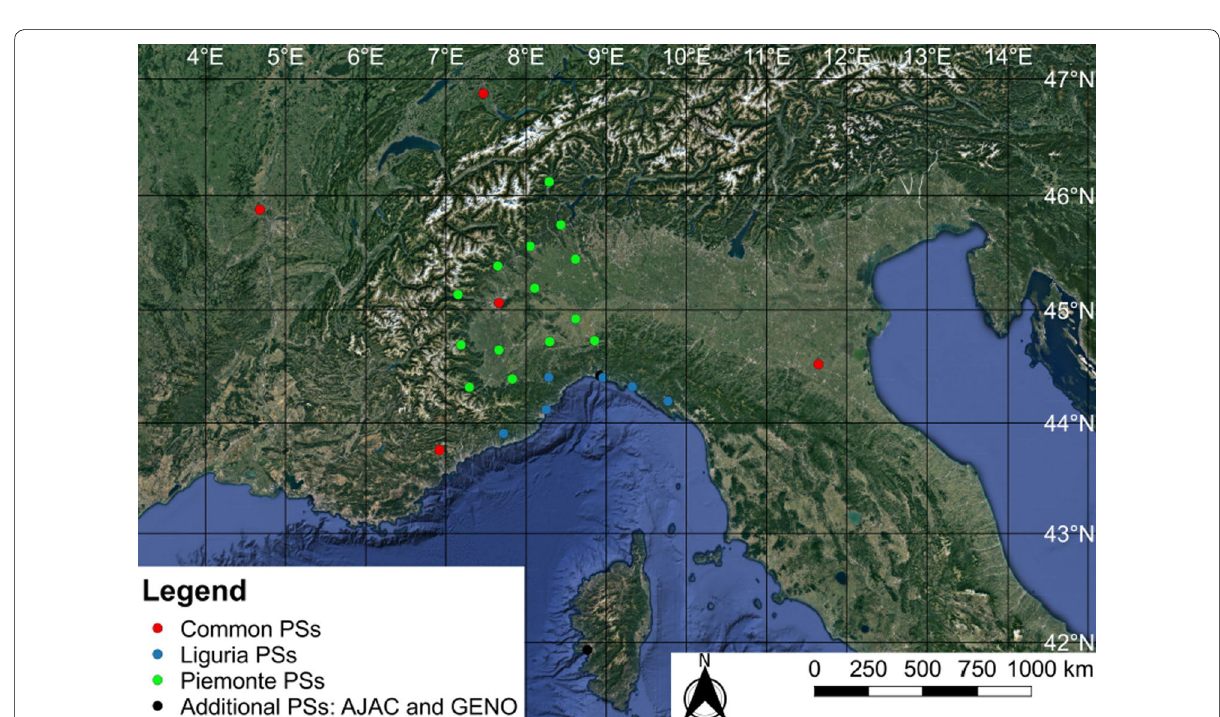
Fig. 14 Permanent stations (PSs) network for near real-time application. Among the 15 common PSs, the 5 PSs in the study area are represented as red dots; Regione Piemonte and Regione Liguria PSs are shown as green and blue dots, respectively; GENO and AJAC are represented as black